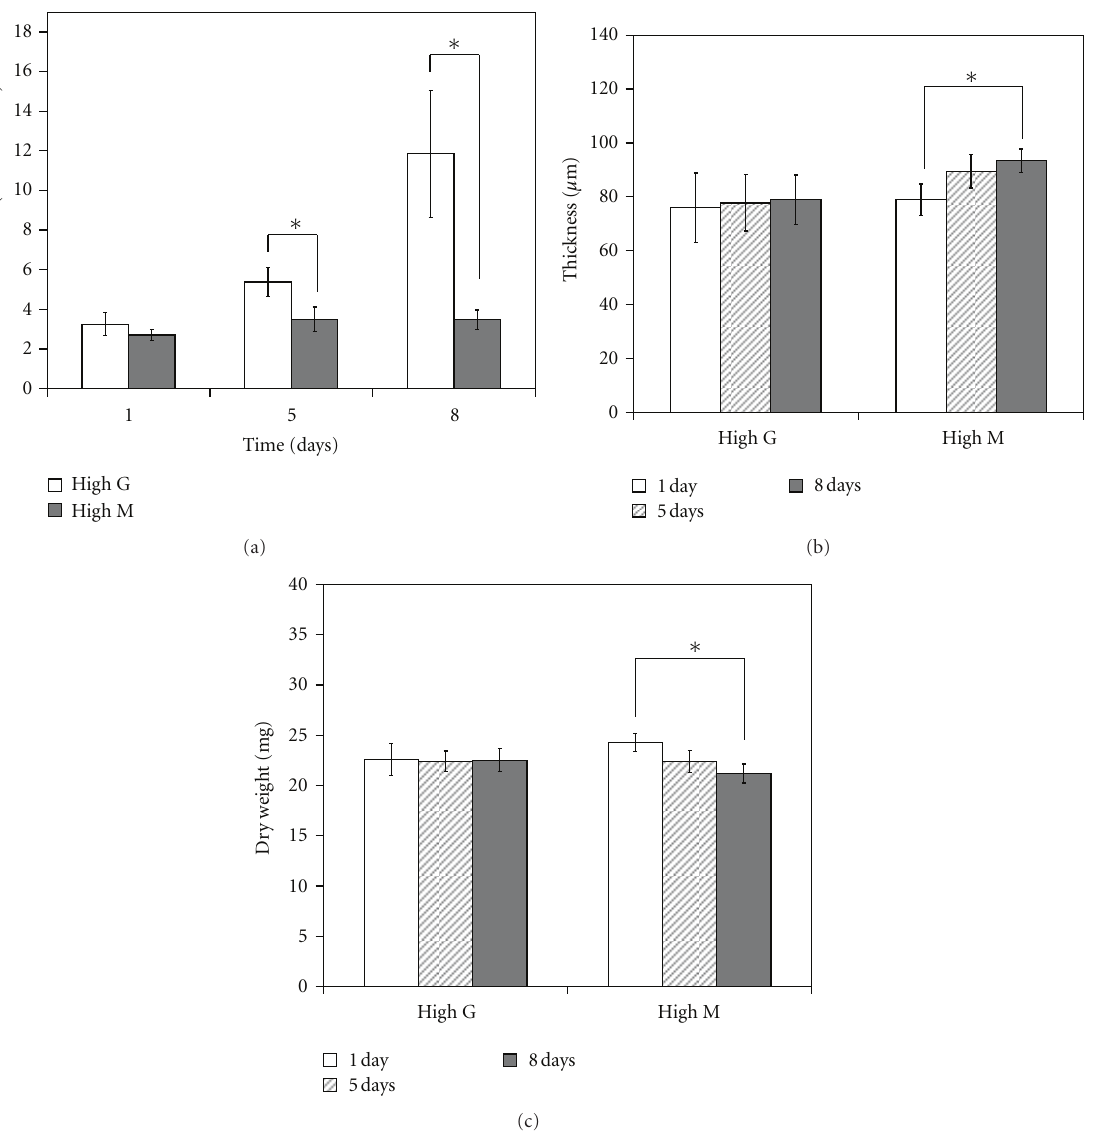
Figure 6: Influence of concentration of ferric ions cross-linked with alginate on the growth of NHDF. Cells were seeded on Fe-alginate gels with a low concentration of ferric ions, being cross-linked with 50 mM FeCl 3 at a density of 4000 cells/cm 2 , and numbers of attached cells were counted at 1, 5, and 8 days after the start of culture (a). Thickness (b) and dry weight (c) were also measured to evaluate the properties of the Fe-alginate gel. Error bars indicate standard deviation for n = 4. ∗ P < 0 .